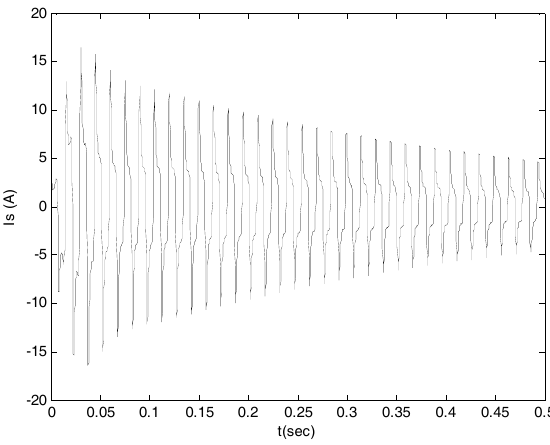
(cid:2929) = 0.22 H.